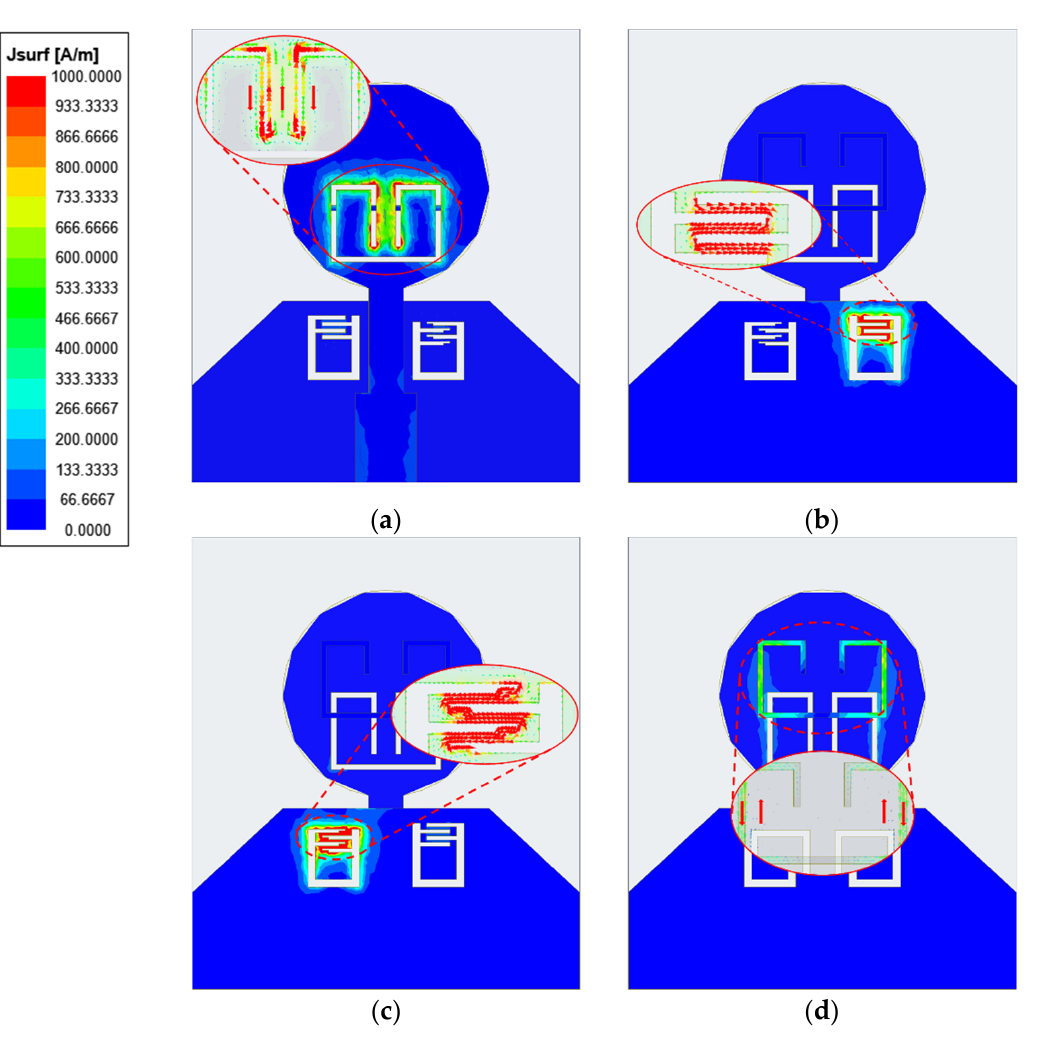
Figure 12. Simulated magnitude of current distribution at ( a ) 3.5, ( b ) 5.2, ( c ) 5.8, and ( d ) 7.6 GHz.